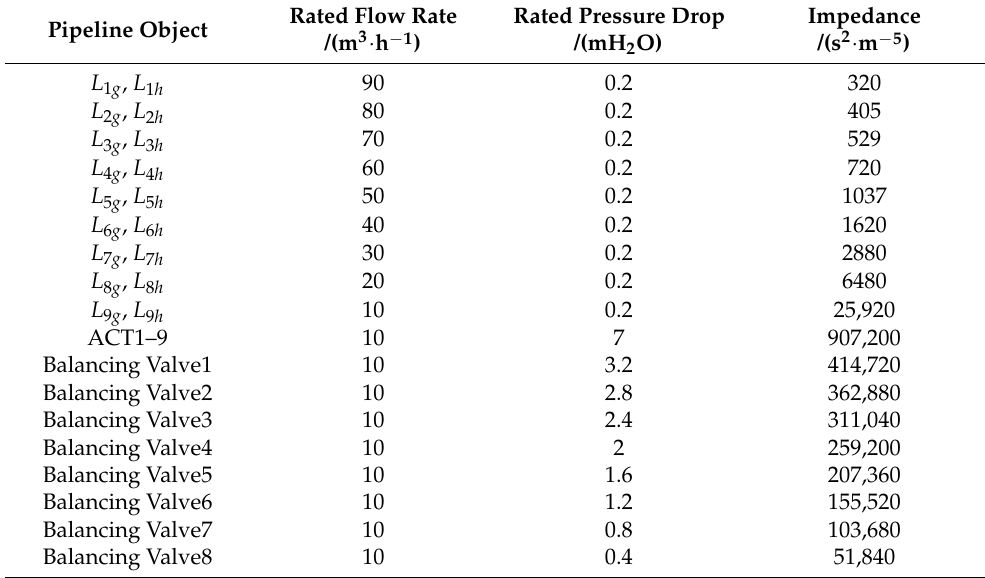
Table 3. Control system measurements.